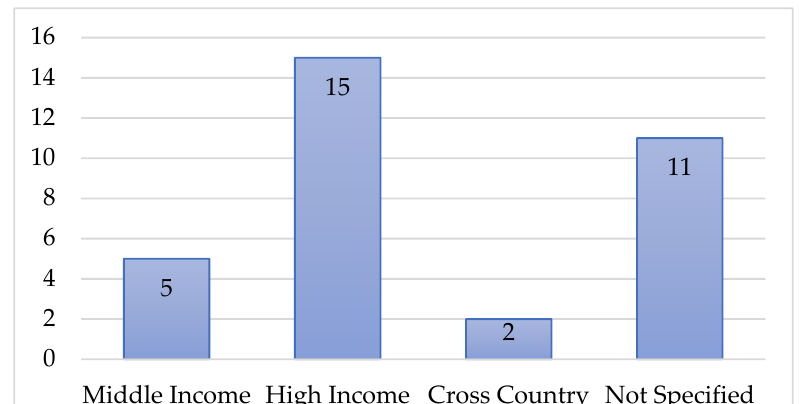
Figure 8 . Country-focus distribution of the papers